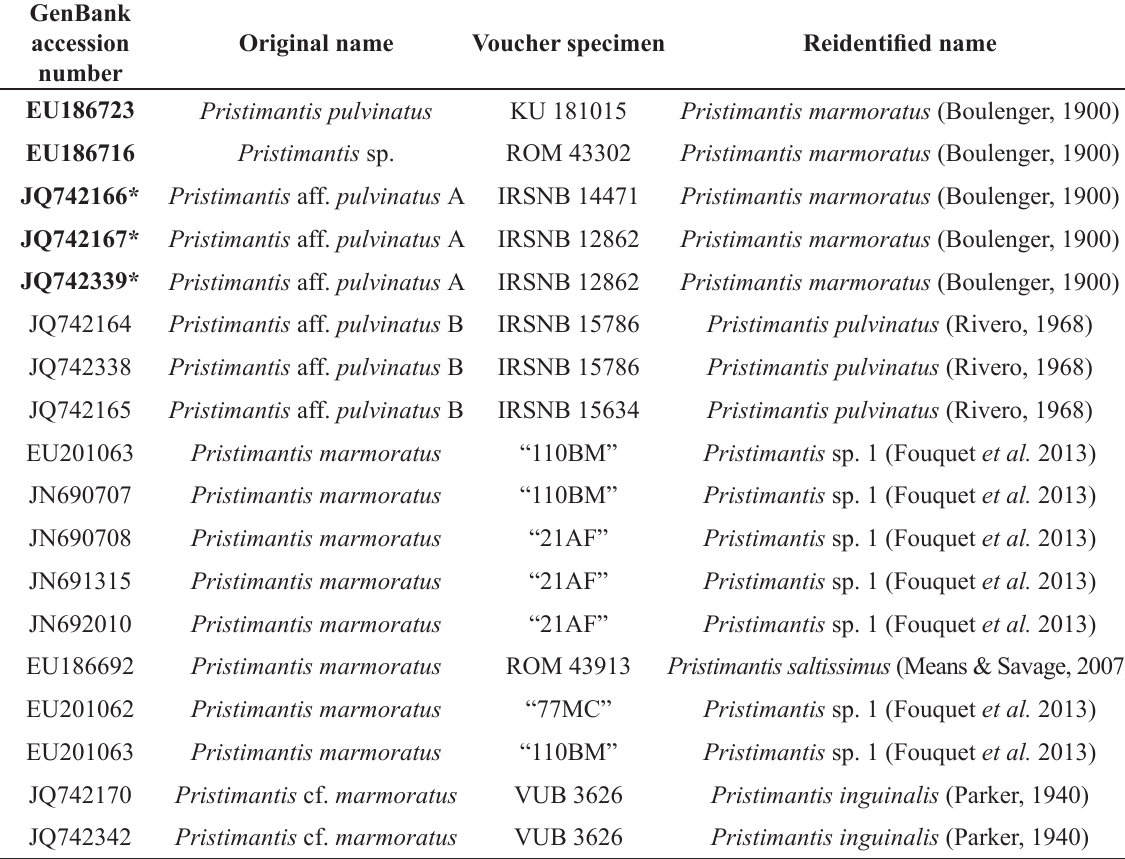
Table 1. Reidentified terminal species names of GenBank. Accession numbers in bold represent Pristimantis marmoratus (Boulenger, 1900). Asterisks highlight sequences of specimens we examined and that correspond to the morphology of the